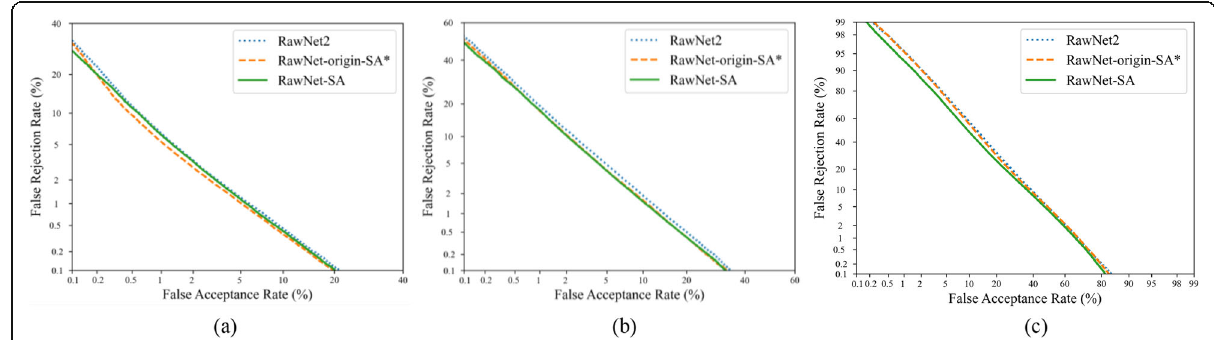
Fig. 7 DET curves of models on different datasets. A VoxCeleb-E. B VoxCeleb-H. C CN-Celeb